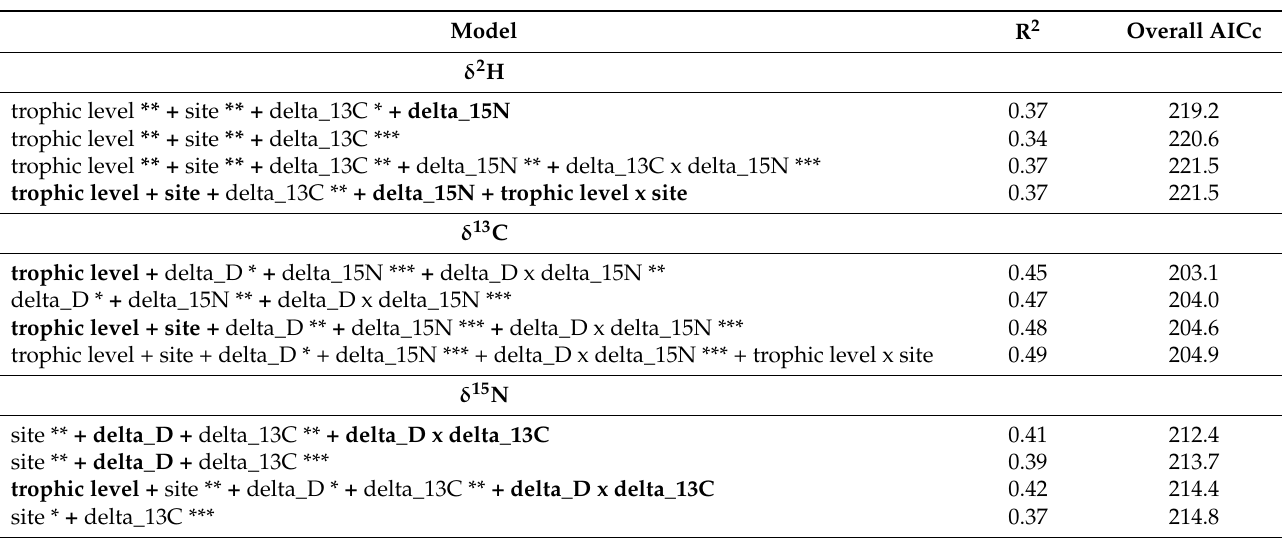
Table 1. Model selection for the various isotopes showing the best four models following the dredge function and their respective R squared and corrected Akaike’s Information Criterion (AICc). Explanatory variables in bold were significant in the model, with asterisks representing the following p -values: * < 0.05, ** < 0.01, *** < 0.001. Model R